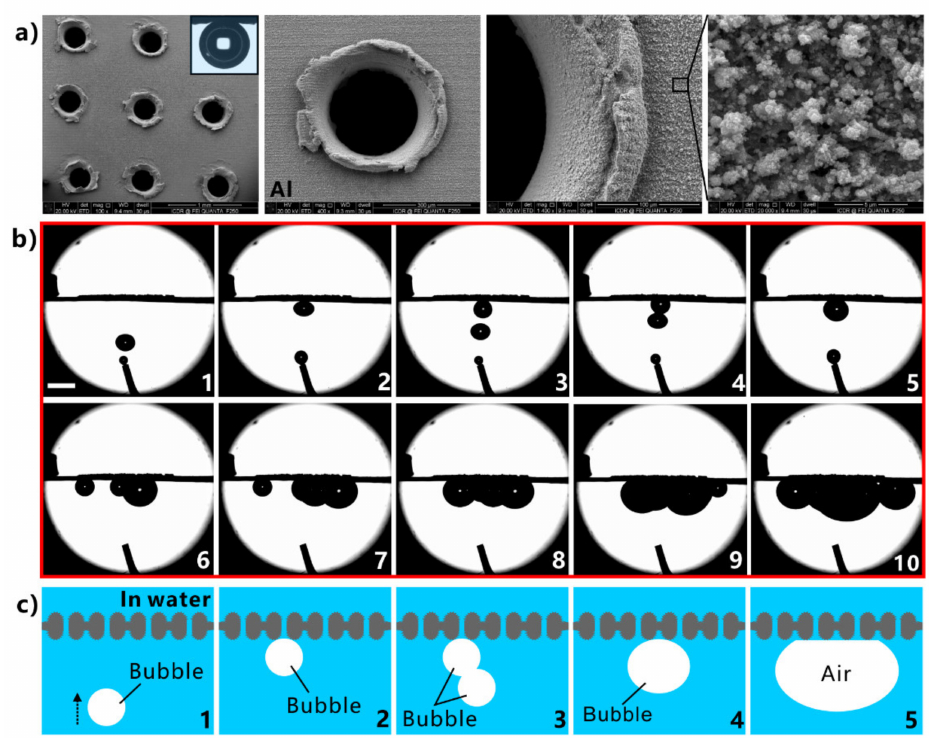
Figure 27. Underwater interception effect of the superaerophobic porous sheet to bubbles. ( a ) SEM images of the porous aluminum sheet. Inset shows a bubble on the structured aluminum sub- strate in water. ( b ) Bubbles continuously rising to the superaerophobic porous sheet underwater. ( c ) Schematic mechanism of the interception function of the underwater superaerophobic porous sheet to underwater bubbles. Reprinted with permission from ref. [46]. Copyright 2017, American Chemical